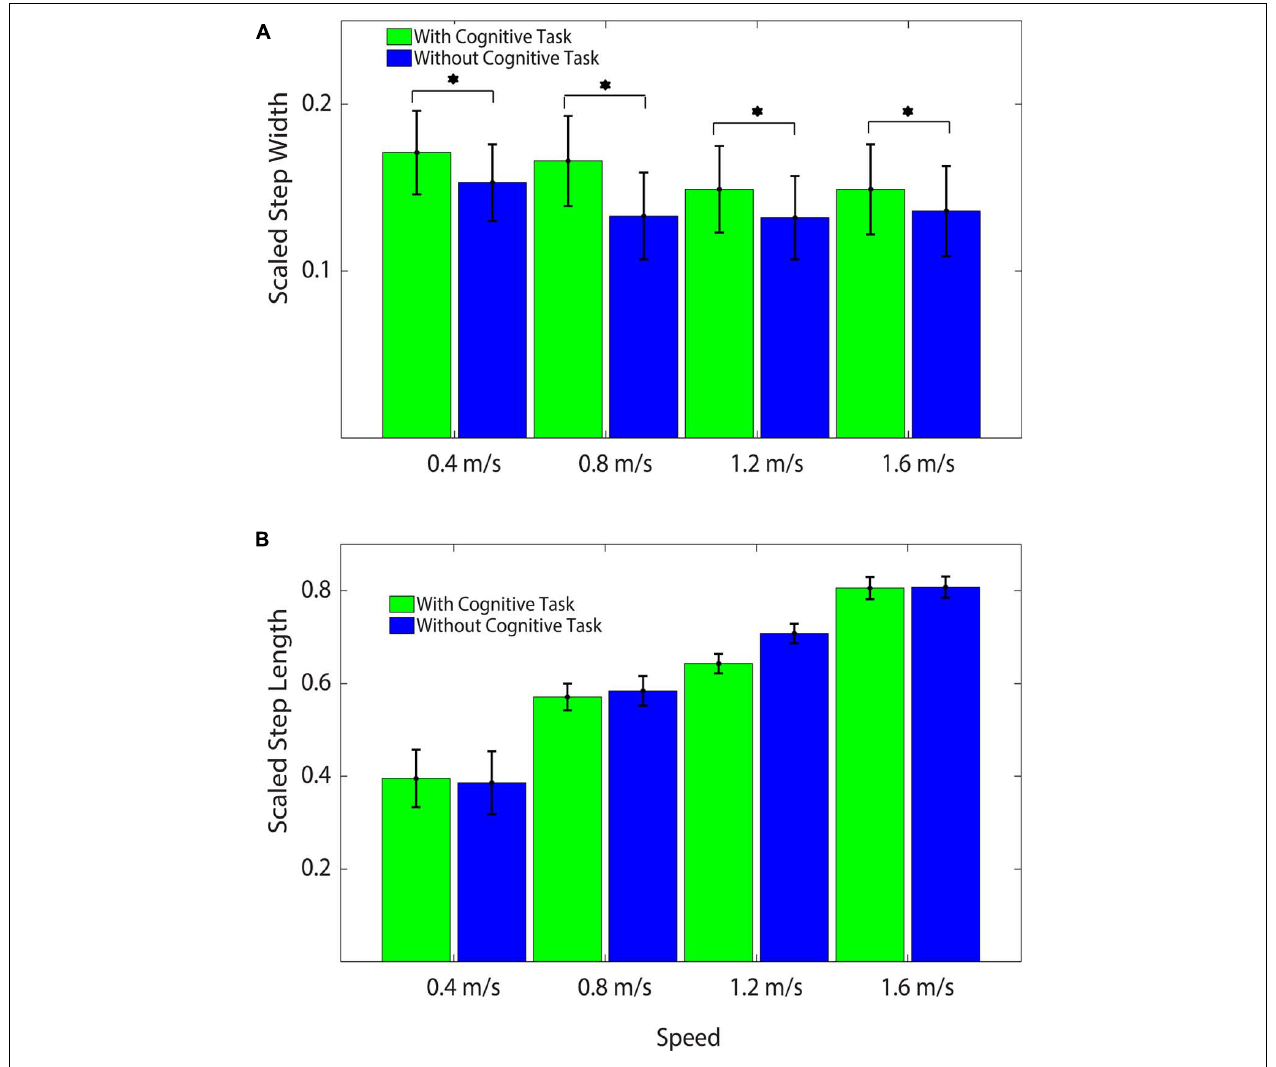
FIGURE 3 | (A) Average Scaled StepWidths at all speeds with and without the cognitive task. Subjects stepped significantly wider with the cognitive task than without the cognitive task at all speeds. Asterisks indicate significant differences between conditions. All values were scaled by each